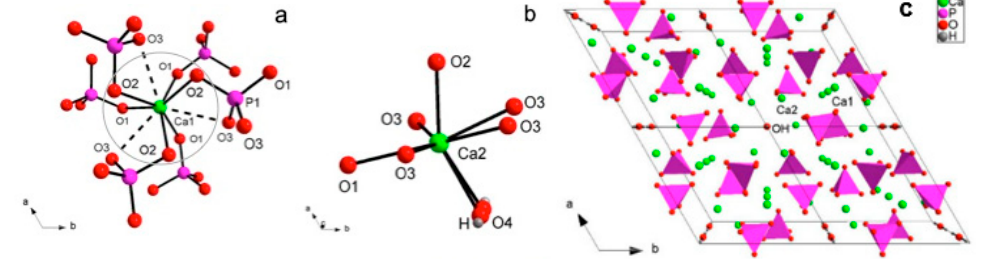
Figure 4. (Ca(1) 4 (PO 4 ) 6 ) 10 − anionic moiety, and (grey inset) detail of CaO 6 polyhedron (dashed lines: Ca-O interactions with bonding character) ( a ); Ca2 coordination environment ( b ); representation, down crystallographic axis c , of the HAp framework ( c